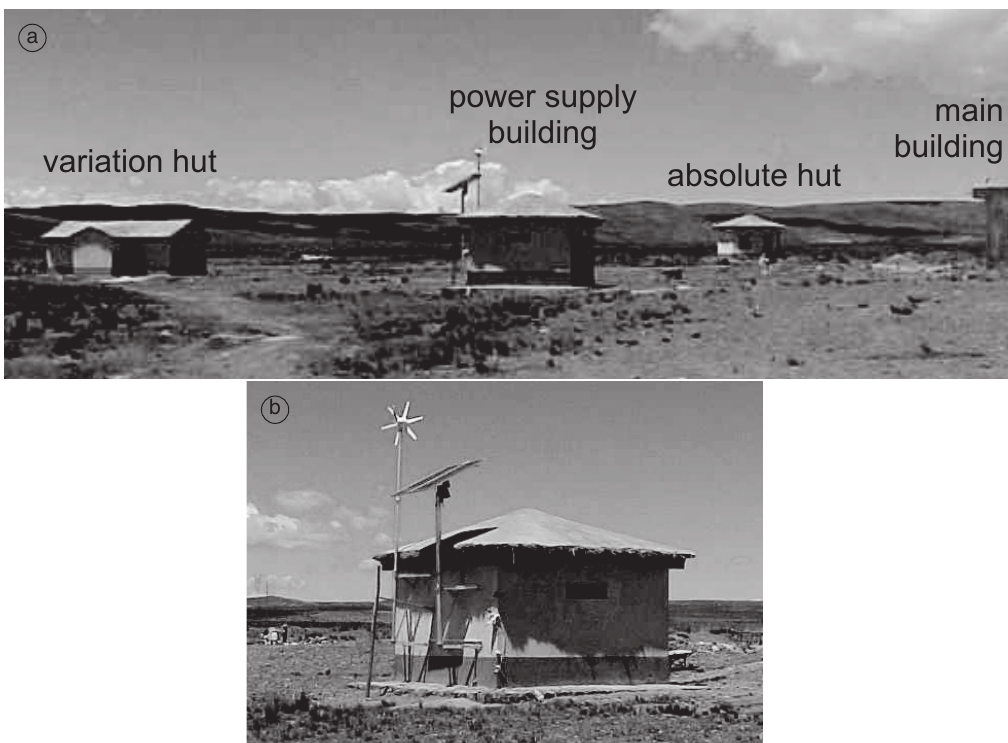
Fig. 3a,b. Observatory buildings at VRE. a) Overview over the observatory premises with a corner of the main building on the right. b) Power supply building with solar panel and wind